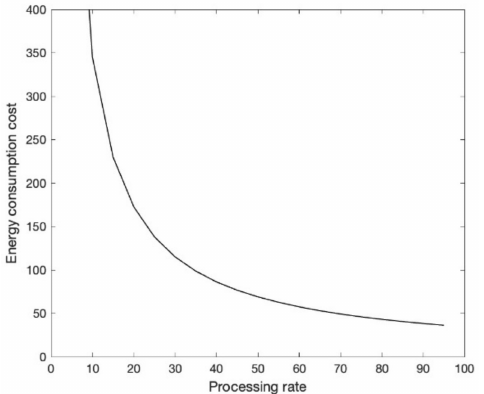
Figure 9. The effect of the processing time of the physical machine on energy consumption cost. When θ = 3, the cloud provider’s strategy is X 1 ∗ = ( 1, 0, 1, 0, 1 ) and the enterprise user can choose one physical machine from PM1, PM3, and PM5 to process the application migration task. The enterprise user needs the shortest application processing time, which is inversely proportional to the processing speed of the physical machines, so the enterprise user chooses PM1 to process the migration task, which means that the enterprise user’s strategy is Y 1 ∗ = ( 1, 0, 0, 0, 0, )